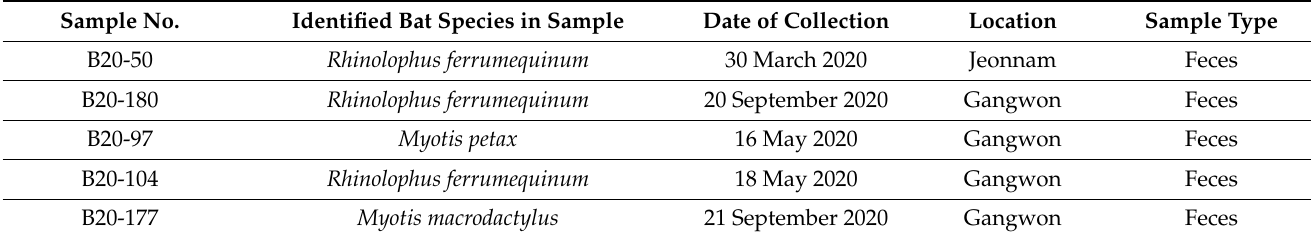
Table 1. Bat sample